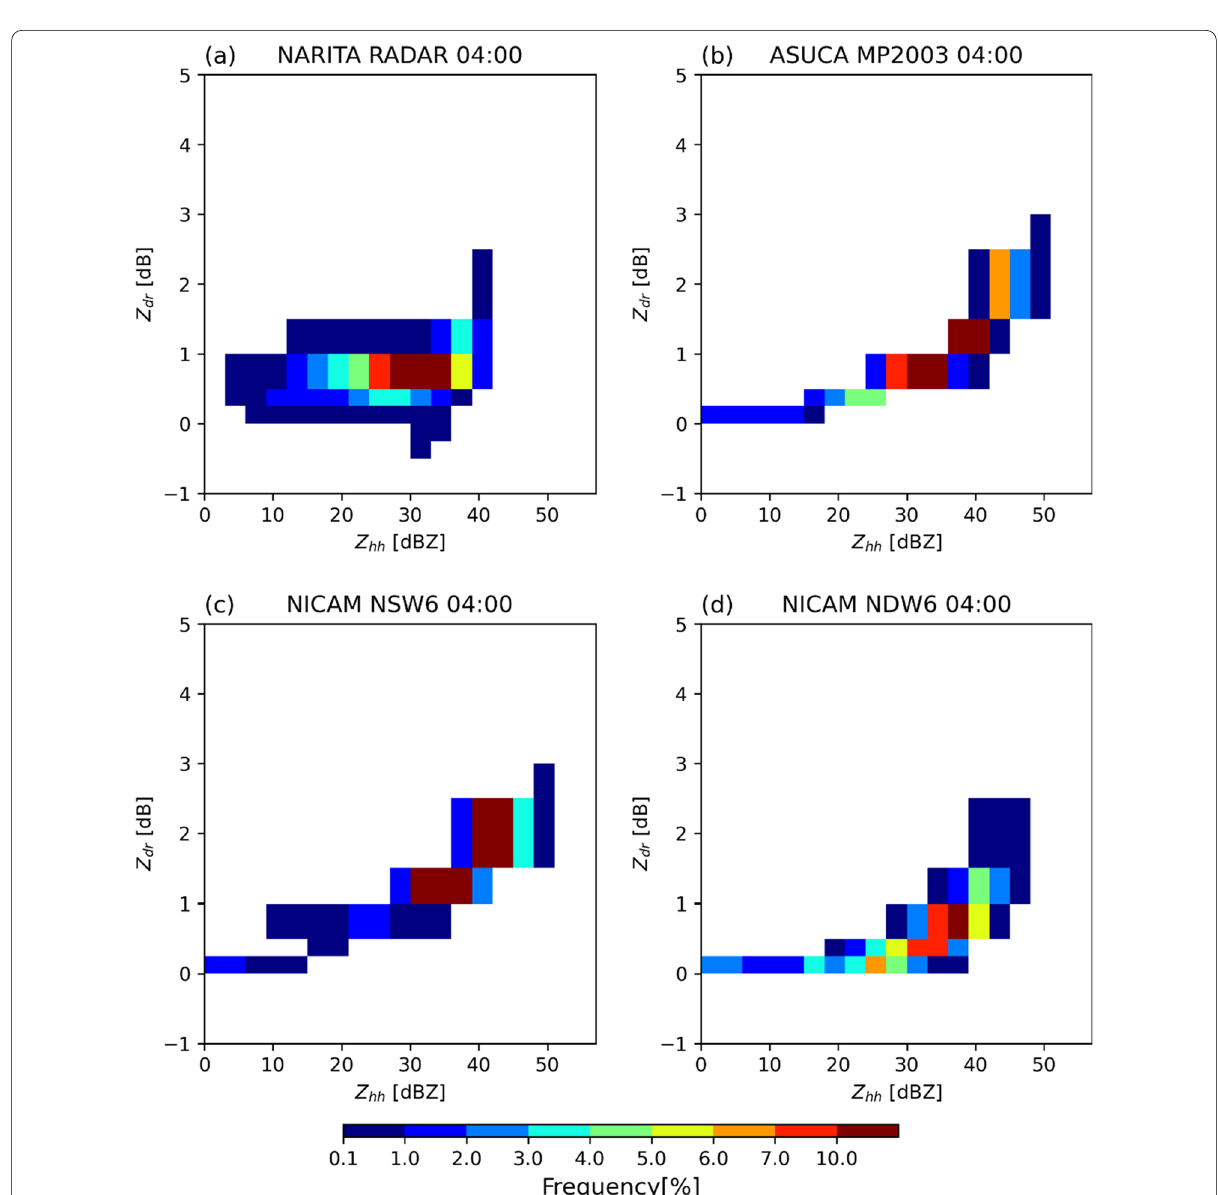
Fig. 18 Joint probability distributions between Z hh [dBZ] and Z dr [dB] at an altitude of 1.75 km at 04:00 UTC, April 18, 2020. a The Narita radar; b ASUCA; c NICAM-NSW6; and d